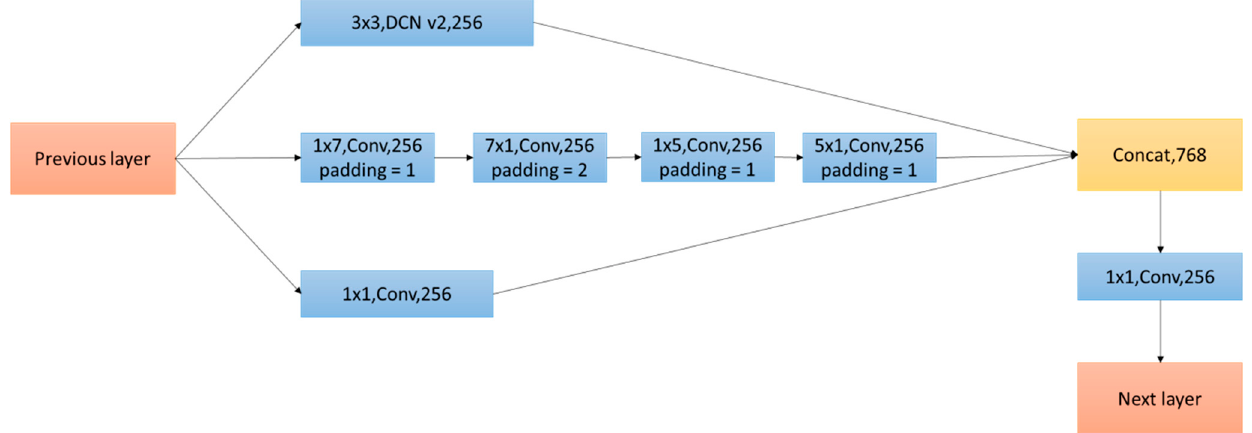
Figure 2. Multi-branched feature extraction (MBFE) module.